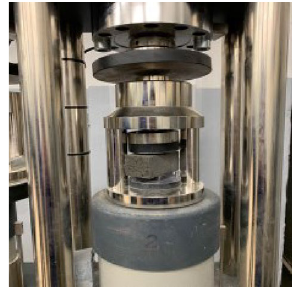
Figure 5. Compressive strength test [Fot. Y.Gu].